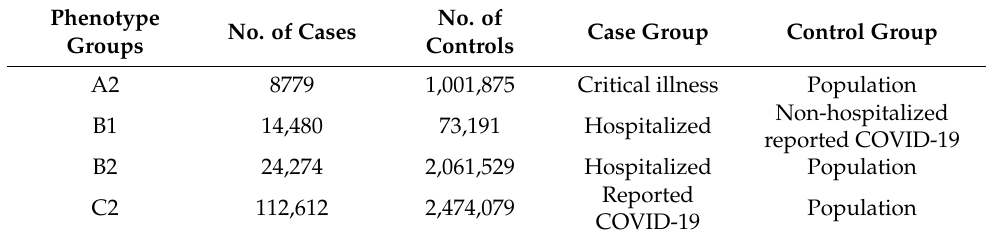
Table 1. Phenotype groups available for COVID-19 GWAS